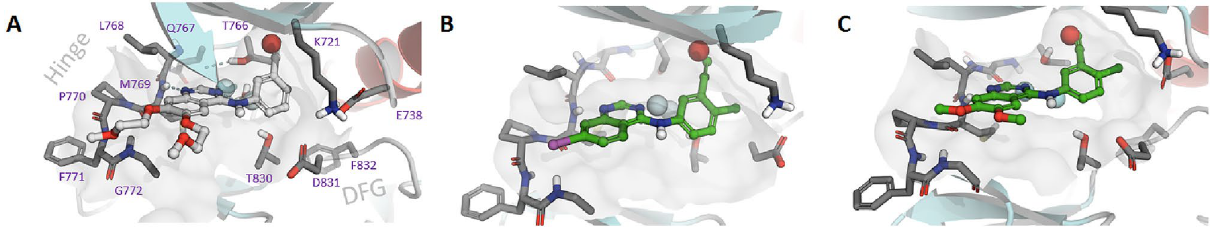
Figure 3. WaterMap simulation of Docking of compounds in the EGFR ATP binding site (PDB:1M17): ( A ) erlotinib, ( B ) 41 and ( C ) 45 . Red sphere shows locations of hight energy hydration site, which is replaced upon ligand binding. Light blue spheres behind the quinazoline scaffold are showing favourable hydration sites at back pocket are acting as bridge between quinazoline ring nitrogen and polar protein